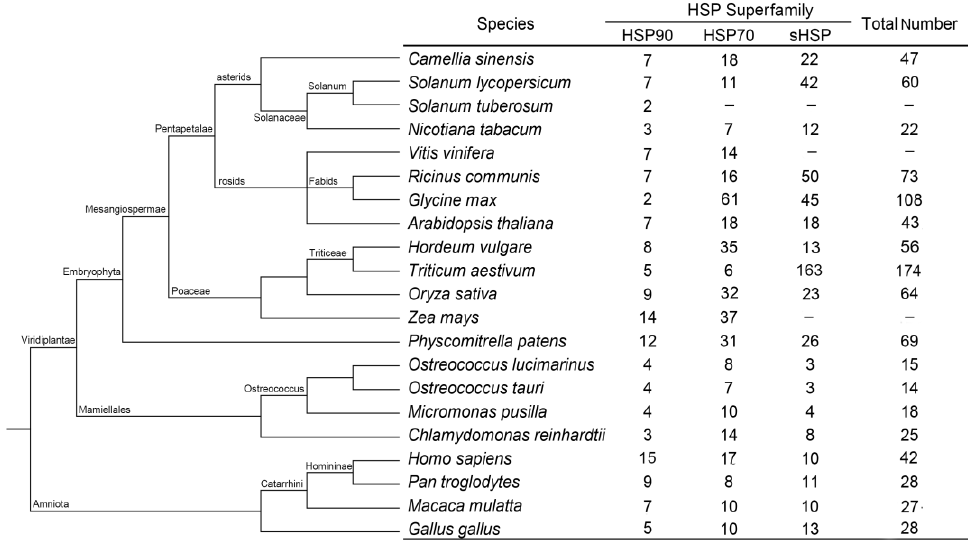
Figure 1. Summary of the HSP (heat shock protein) gene superfamily among 21 species.